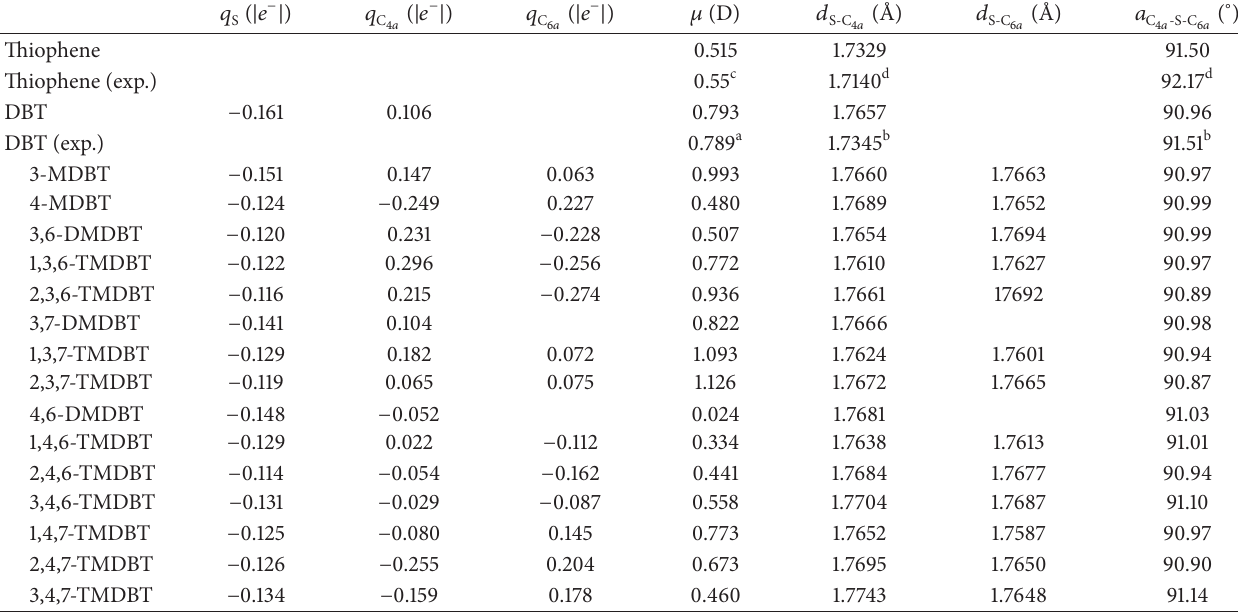
Table 1: Electrostatic and geometric properties at the ground state for DBT and its methyl, dimethyl, and trimethyl derivatives, calculated using the DFT, the B3LYP/6-311+G(d,p) basis set, and the Merz-Kollman population analysis [20]: charge of the sulfur atom, 𝑞 𝑞 , the C 6𝑎 atom, 𝑞 , the dipole moment, 𝜇 , the bond distances, 𝑑 , and the bond angle, 𝑎 . The calculated and experimental data for DBT C 4𝑎 C 6𝑎 and thiophene are reported for